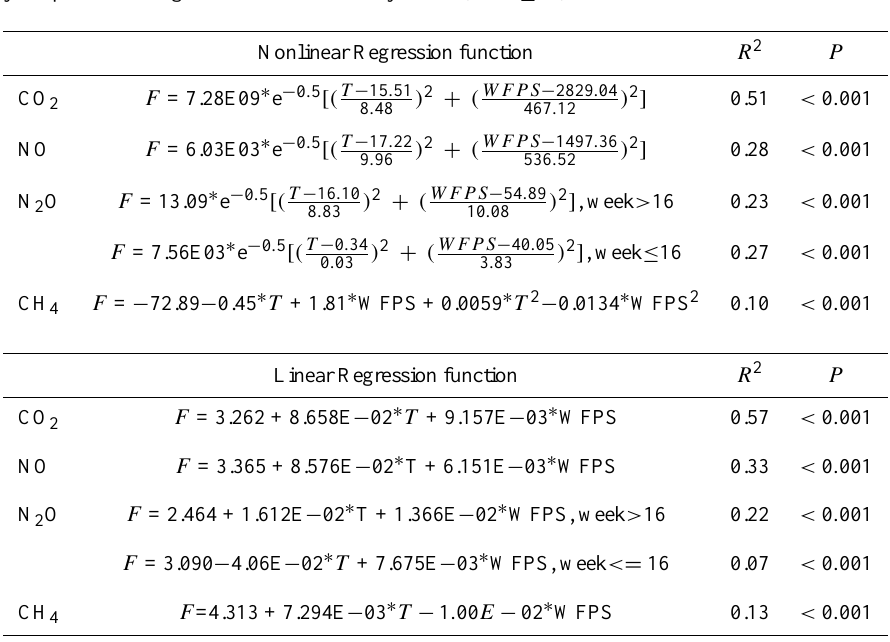
Table 4. Results from linear (log-transformed date) and non-linear regression analysis of soil N 2 O [ µ gNm − 2 h − 1 ], NO [ µ gNm − 2 h − 1 ], regressions separately for periods during which freeze-thaw may occur (week ≤ 16).